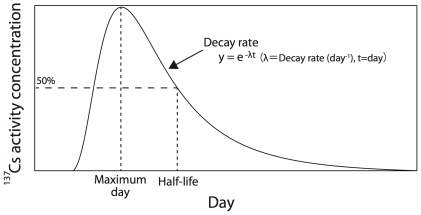
Illustration of the conceptual decay processes of 137Cs activity concentration in fish bodies.